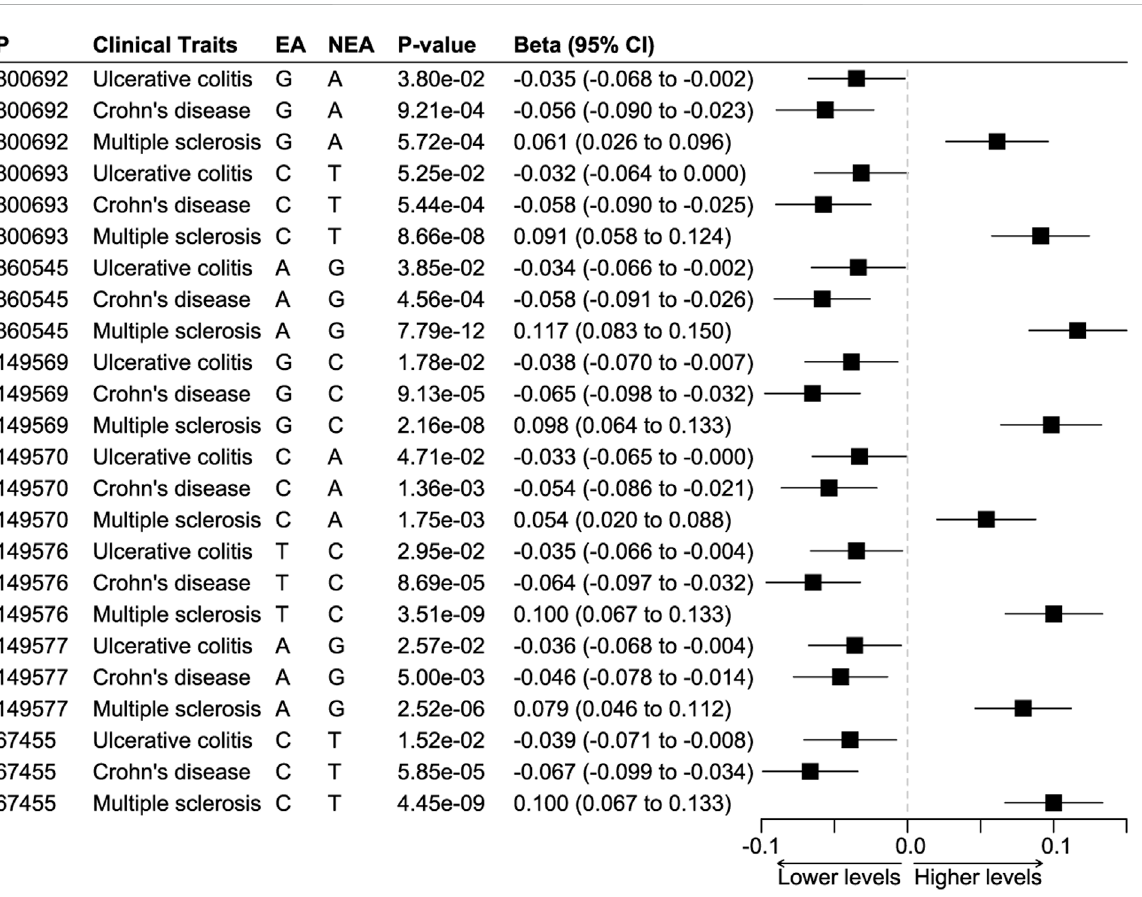
FIGURE 2 Positive control analyses. Abbreviations: EA, effect allele. NEA, non-effect allele. SNP, single nucleotide polymorphism. Footnotes: The results showed that all SNPs were associated with signi fi cantly lower odds of ulcerative colitis and Crohn ’ s disease but higher odds of multiple sclerosis.